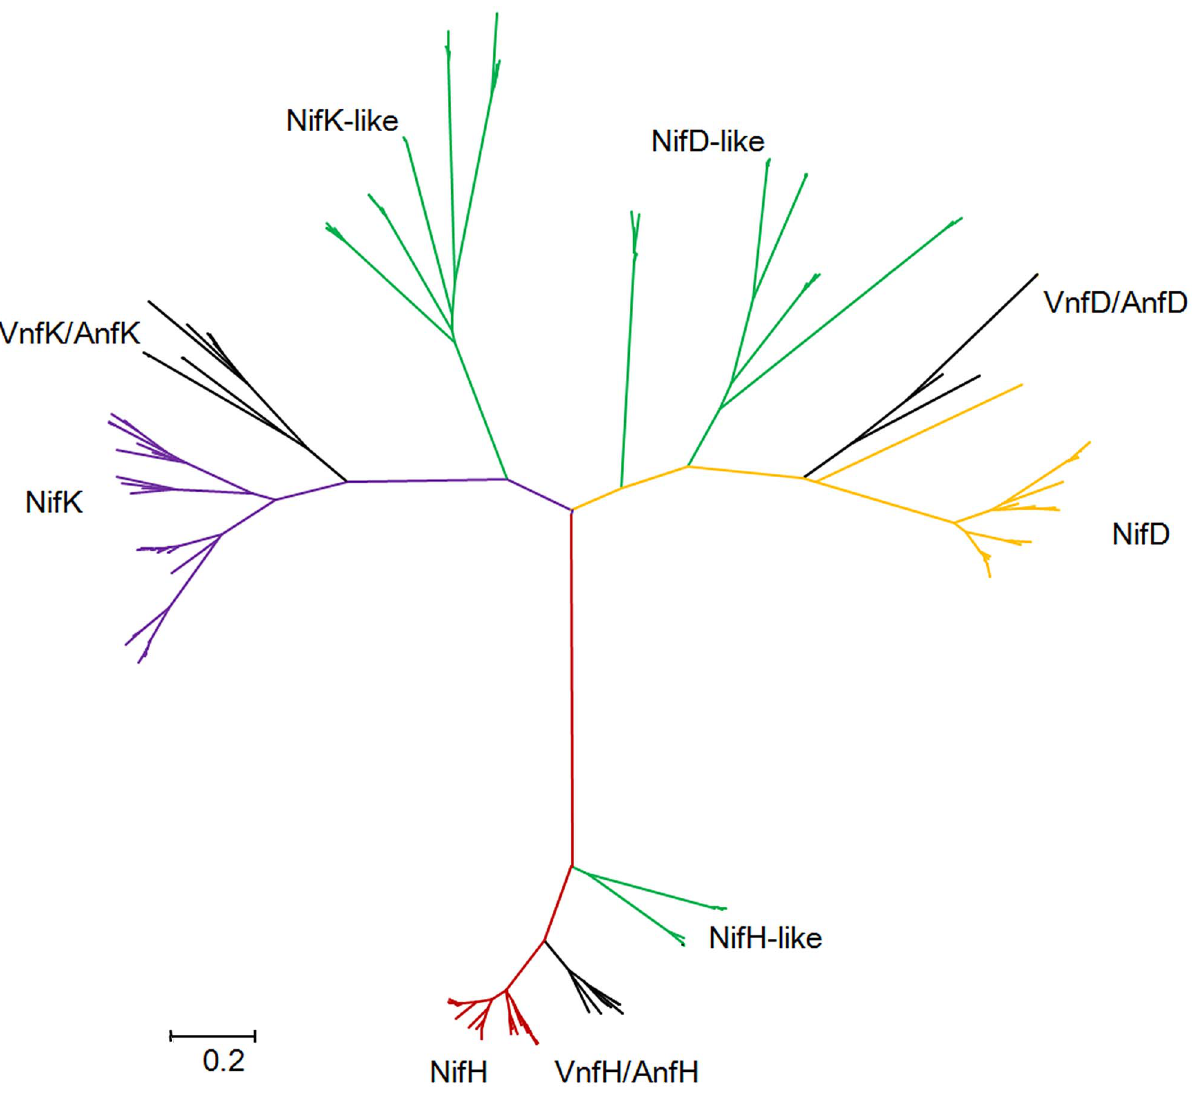
Figure 8. Maximum-likelihood phylogenetic tree of Mo-, Fe- and V-nitrogenases and nitrogenase-like sequences. Nif/Vnf/AnfH, Nif/ Vnf/AnfD, Nif/Vnf/AnfK, Nif/Vnf/AnfH-like, Nif/Vnf/AnfD-like and Nif/Vnf/AnfK sequences were derived from the 15 N 2 -fixing Paenibacillus strains and other representative species. doi:10.1371/journal.pgen.1004231.g008 PLOS Genetics |